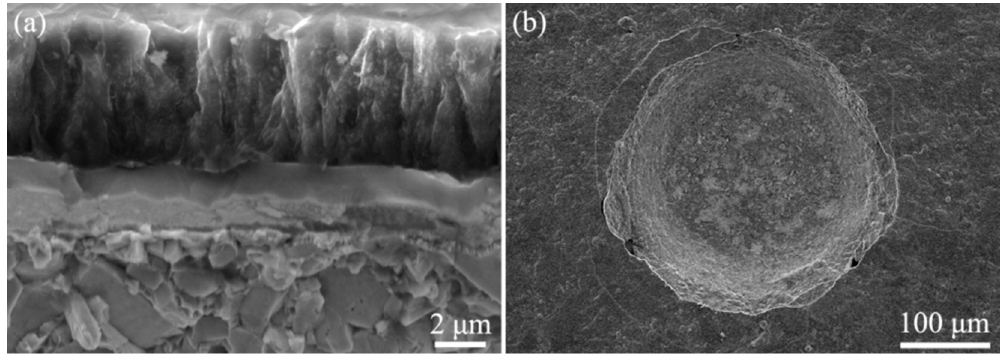
Figure 11. (a) Cross-sectional morphology of the diamond/HfC-SiC multi-coated substrate and (b) Figure 11. ( a ) Cross-sectional morphology of the diamond / HfC-SiC multi-coated substrate and Rockwell C indentation on it. ( b ) Rockwell C indentation on